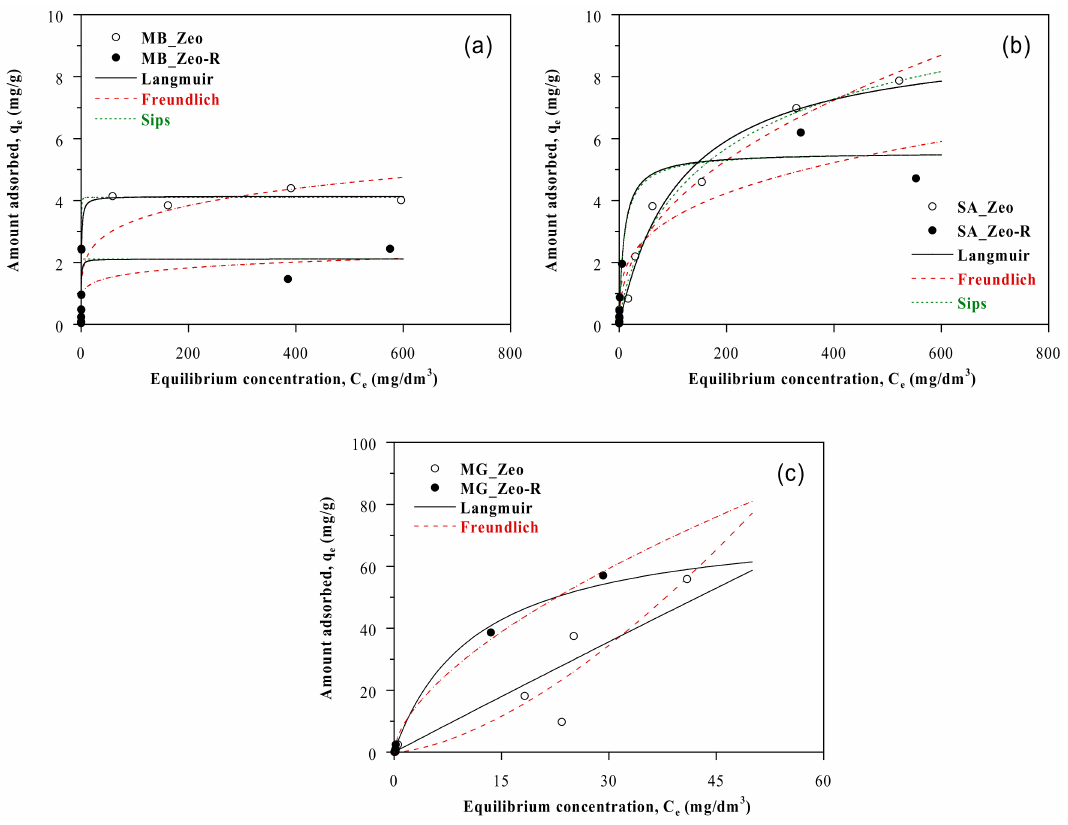
Figure 5. Equilibrium adsorption data for Zeo and Zeo-R as adsorbents and MB ( a ), SA ( b ), and MG ( c ) dyes as